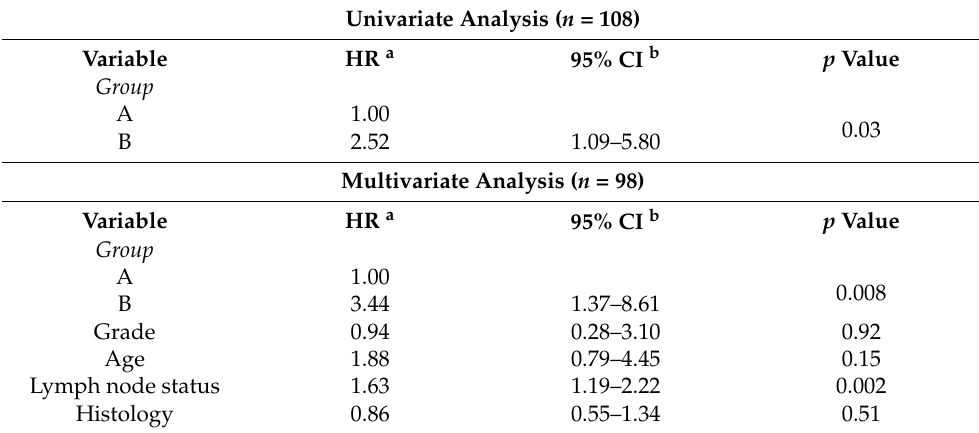
Table 6. Cox univariate and multivariate regression analysis for the prediction of overall survival (OS) after stratification of study cohort according to combination of the rs822336 G>C and rs822337 T>A